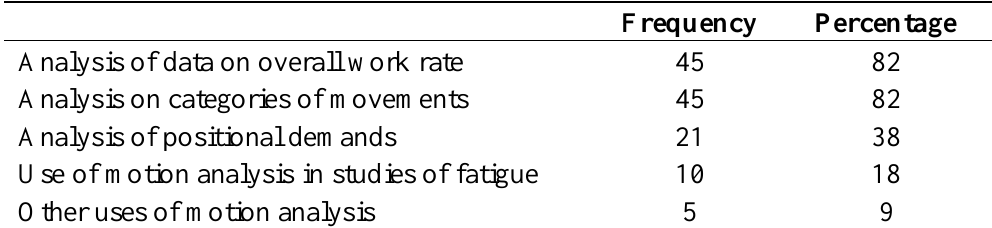
Table 2. Allocation of time-motion analysis